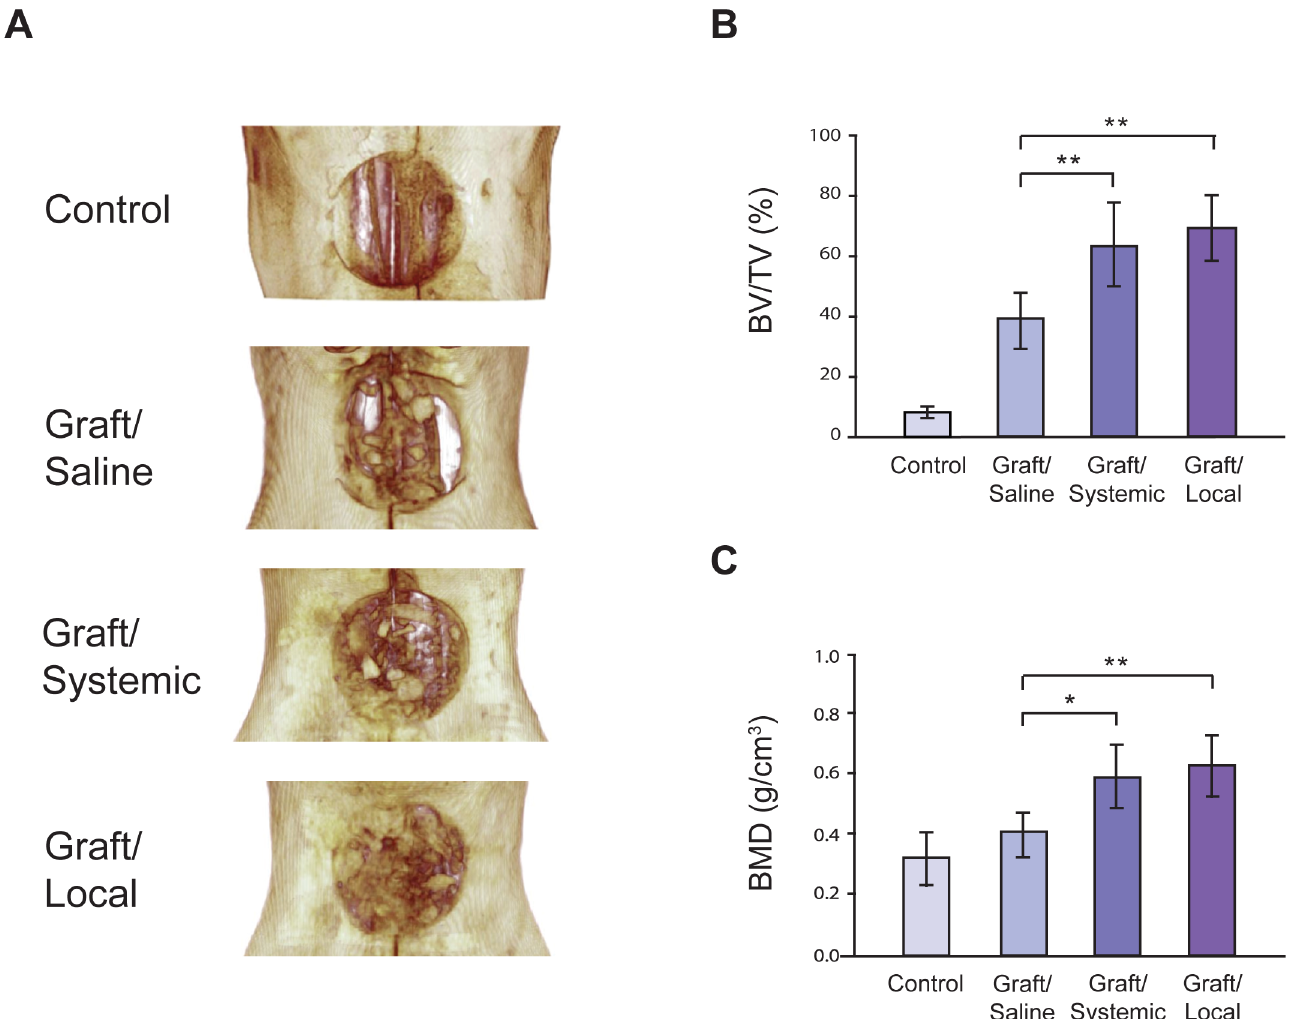
Fig 2. MicroCT images and 3D volumetric analysis. (A) 3D image reconstruction of palatal defect and grafting six weeks after surgery. Quantification of bone volume by volumetricanalysisof microCT images for the control and three experimental groups (n = 8); (B) bone volume fraction (BV/TV) and (C) bone mineral density (BMD). * = p < 0.05, ** = p < 0.01.